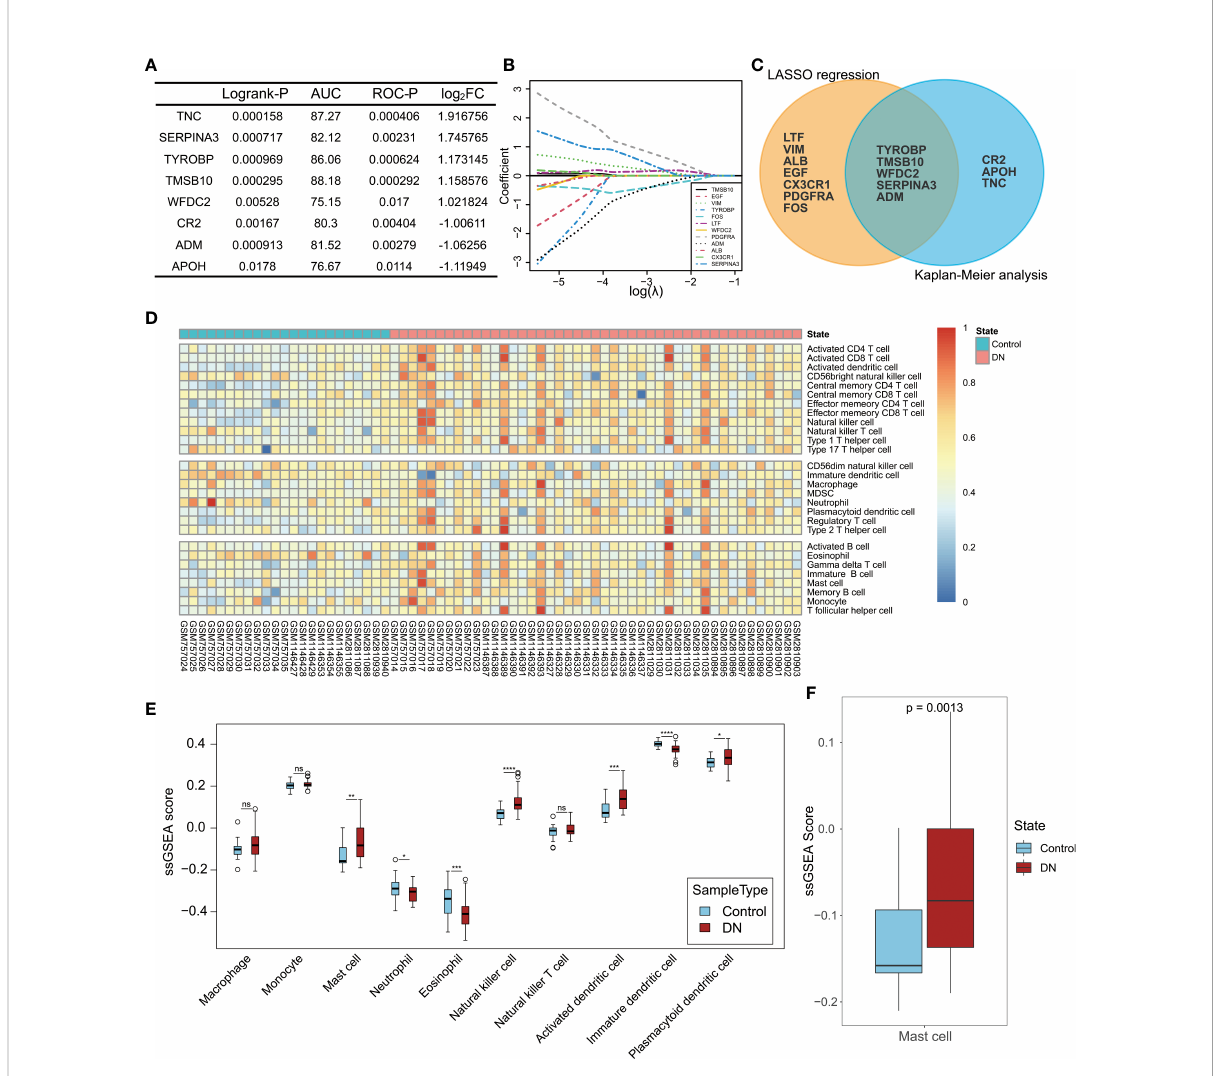
FIGURE 6 Hub gene selection and landscape of immune cell in fi ltration in DN. (A) Statistical indexes of Kaplan – Meier analysis for eight IRDEGs screened through dbPKD. Logrank-P value < 0.05 and ROC-P value < 0.05 were considered statistically signi fi cant. (B) Lasso regression analysis. The expression levels of 32 IRDEGs were used as input values for lasso selection. The fi nal lasso regression model retained 12 IRDEGs. (C) Results of survival analysis and lasso regression screening were intersected to obtain fi ve immune-related differentially expressed genes. (D) Heatmap of 22 subpopulations of immune cells between DN and normal kidney tubular tissue. (E) Difference in the estimated immune cell in fi ltration level between patients with DN and healthy controls. (F) Comparison of the estimated mast cell in fi ltration level between patients with DN and healthy controls. P value < 0.05 was considered statistically signi fi cant. *P < 0.05, **P < 0.01, ***P < 0.001 and ****P < 0.0001; ns, not statistically signi fi